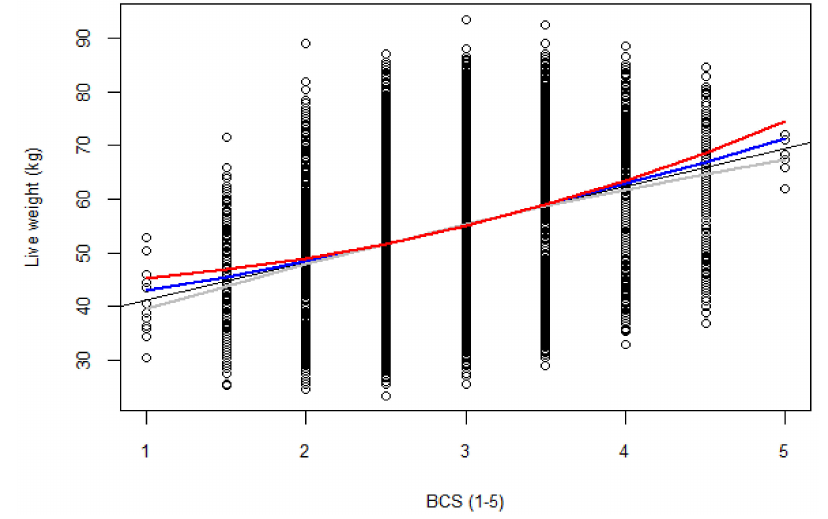
Figure 1. Ewe liveweight (kg) as a function of BCS (1–5). Line of best fit is given for (linear model (SLM), black color; quadratic transformation (QUAD), grey; Box-Cox transformation (Box-Cox), red; and square root transformation (SQRT),